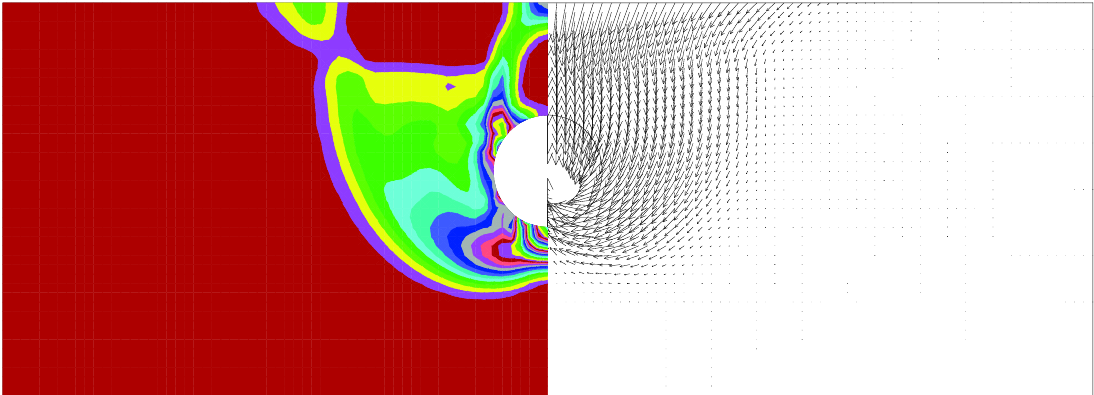
Figure 10. Shear strain rate (SSR) and velocity plot for C/D = 1, γD/S u = 5.